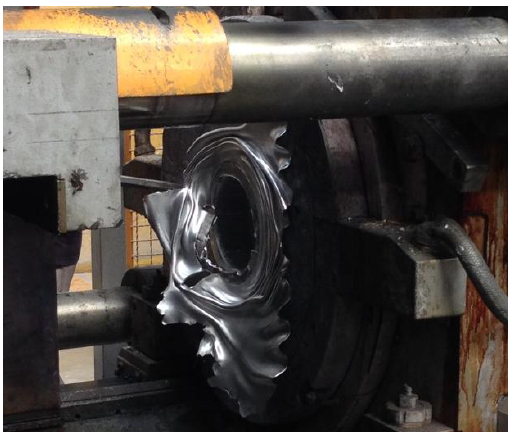
Figure 11. The flash overflow of the material without billet buckle angle in the upper die.